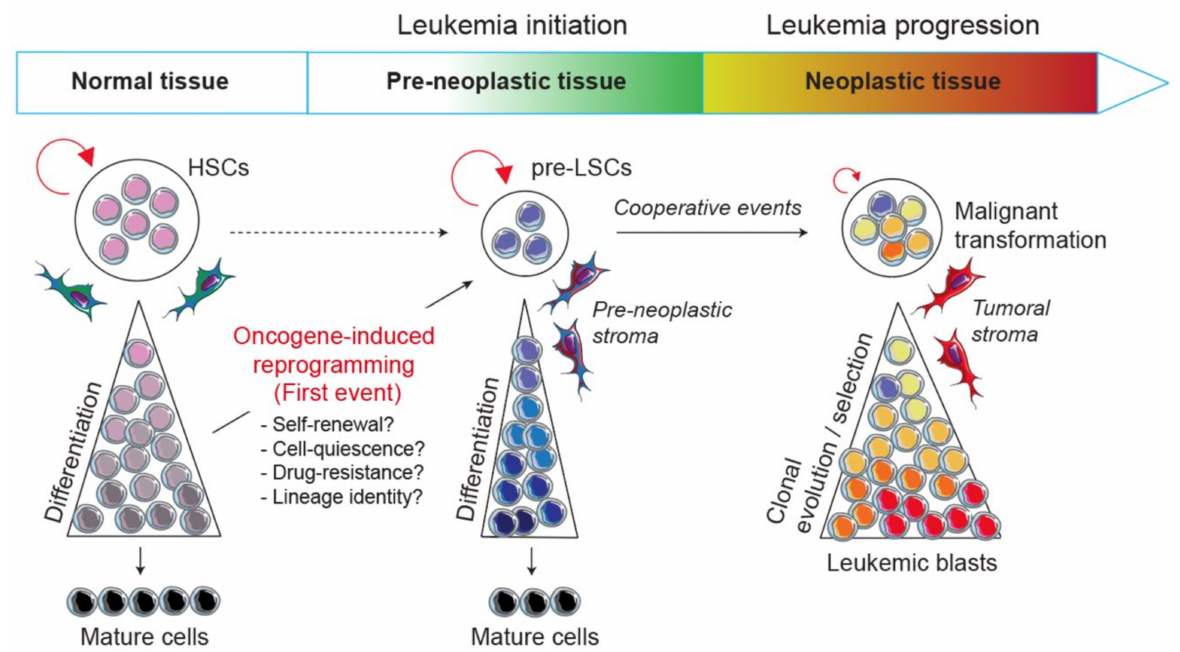
Figure 1. Model of leukemic evolution. A first oncogenic event can either convert a normal HSC or reprogram a normal committed progenitor into a self-renewing pre-LSC. Thus, pre-LSCs are the first cells carrying the initial pre-leukemic lesion but are still able to differentiate and give rise to mature cells. Next, following secondary and cooperative events transform pre-LSCs into malignant leukemic cells that are subjected to clonal evolution and selection